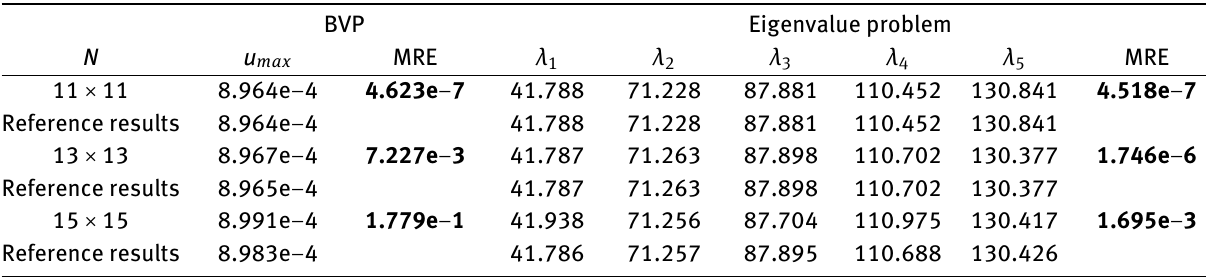
Table 5: The results from solving the biharmonic problems on the triangular domain with corner cut-out. The boundary conditions given by Eq. (28) implemented using strategy 1.